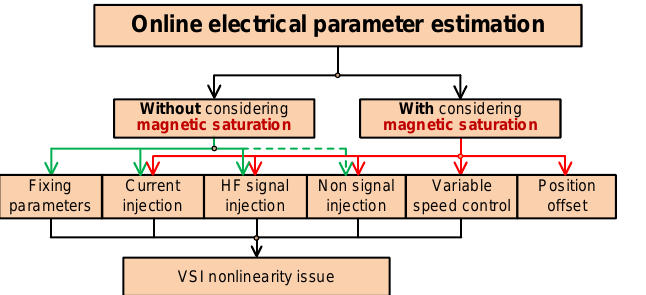
Figure 33. Overview of state-of-the-art online electrical parameter estimation methods [33].